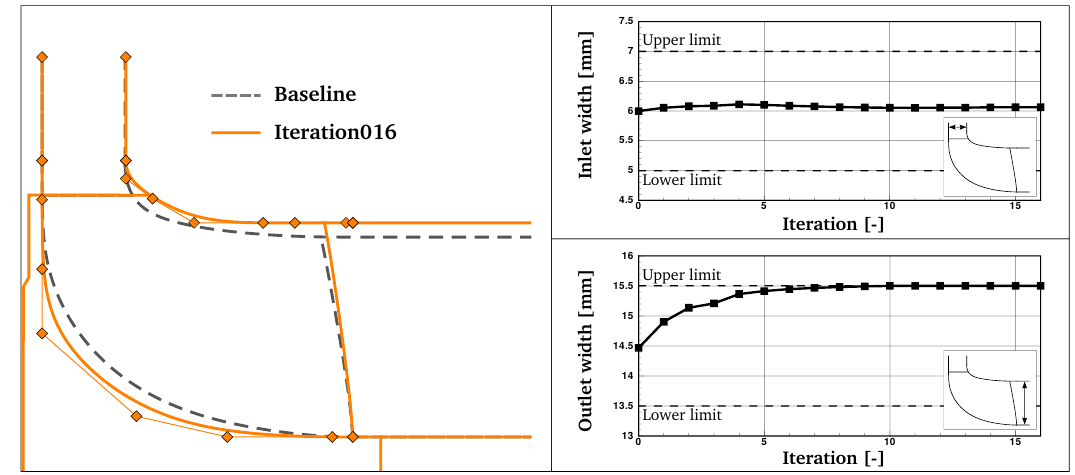
Figure 12. Comparison of the meridional contour of the baseline and optimized geometry ( left ). Evolution of inlet and outlet width during the optimization process ( right